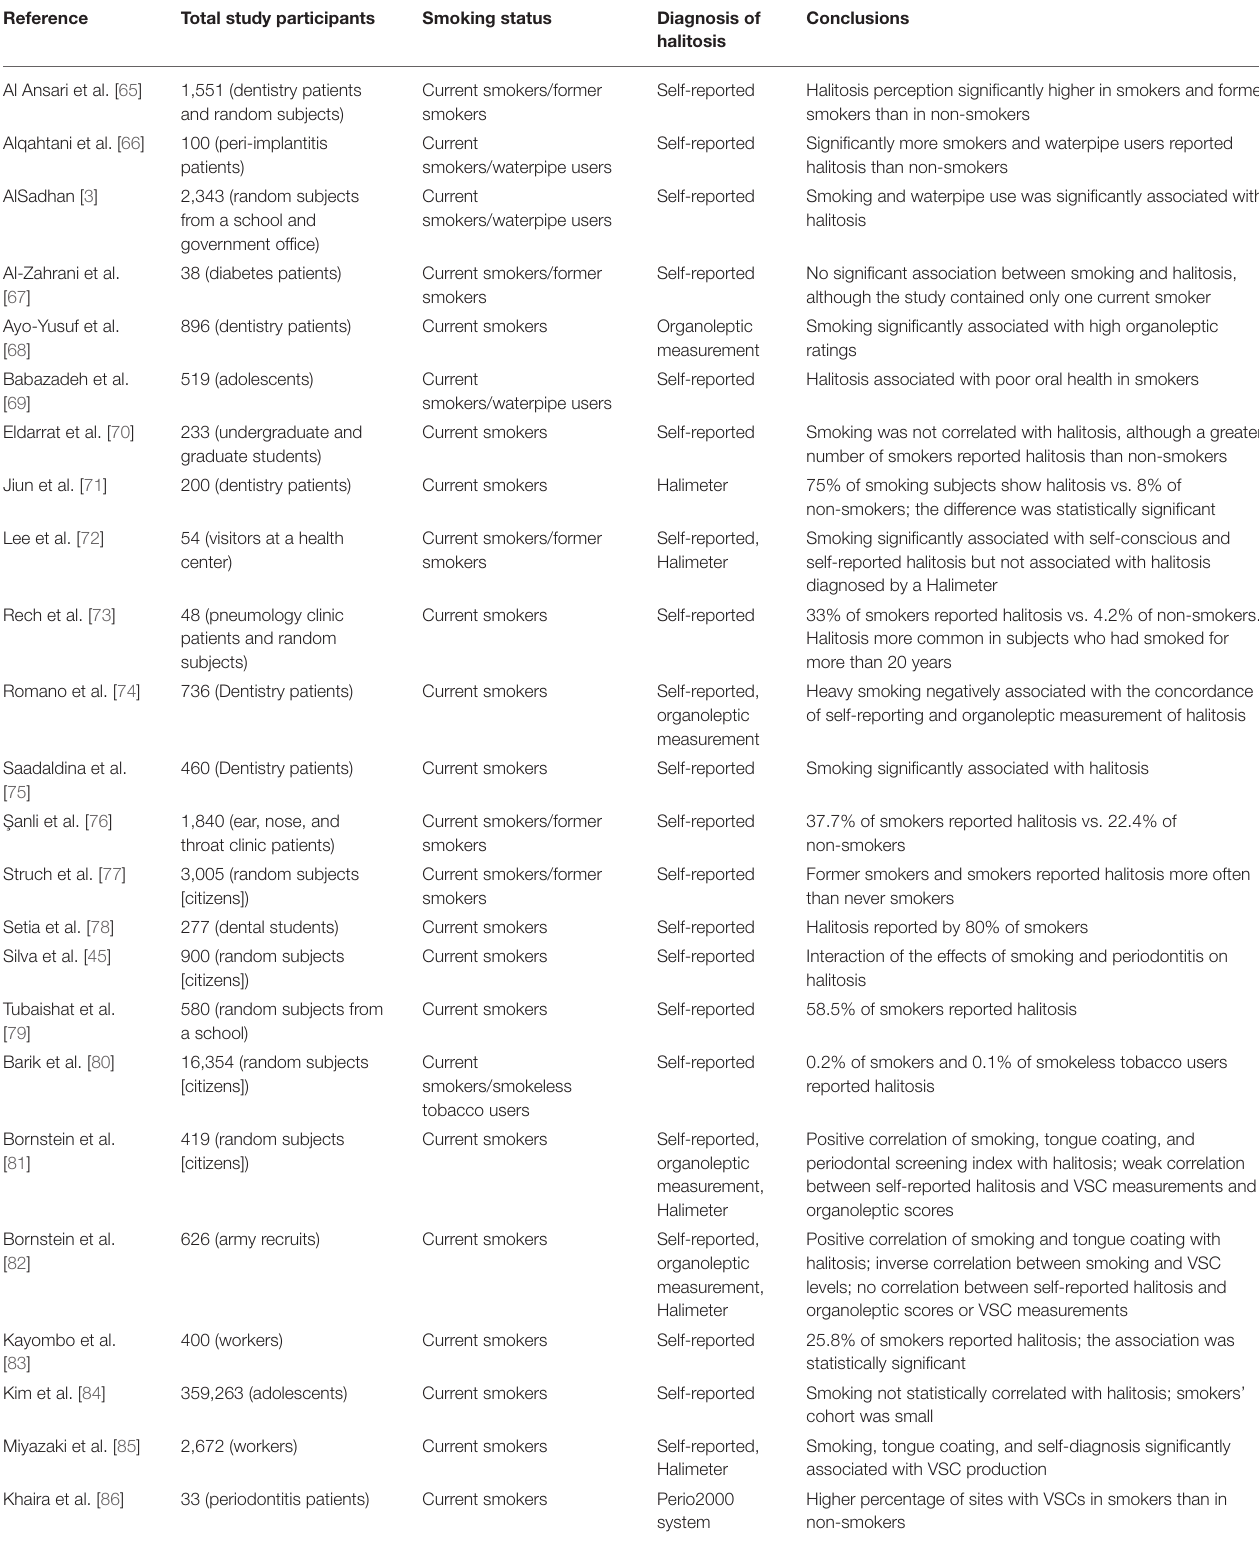
TABLE 1 | Studies that have investigated the impact of cigarette smoking on